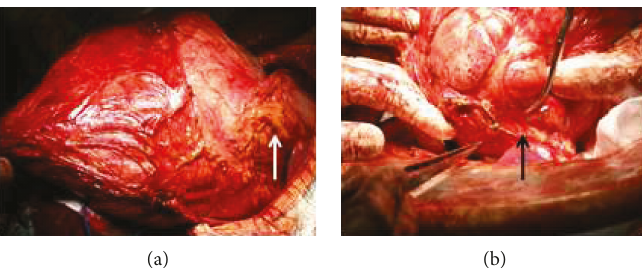
Figure 4: (a) Operative fi ndings: the tumor was attached to the stomach and omentum (white arrow). (b) Operative fi ndings: tumor also adhered to the pancreatic tail (black arrow).